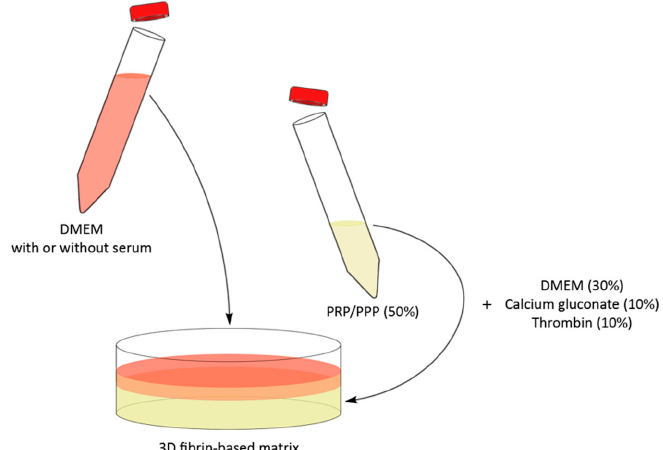
Figure A1 . Graphic representation of 3D fibrin-based matrix preparation. The 3D matrix (yellow) was supplementation (see different experimental set-ups described in Materials and Method). FBS was not used to prepare the 3D matrix. Cells were seeded inside the 3D fibrin-based matrix.